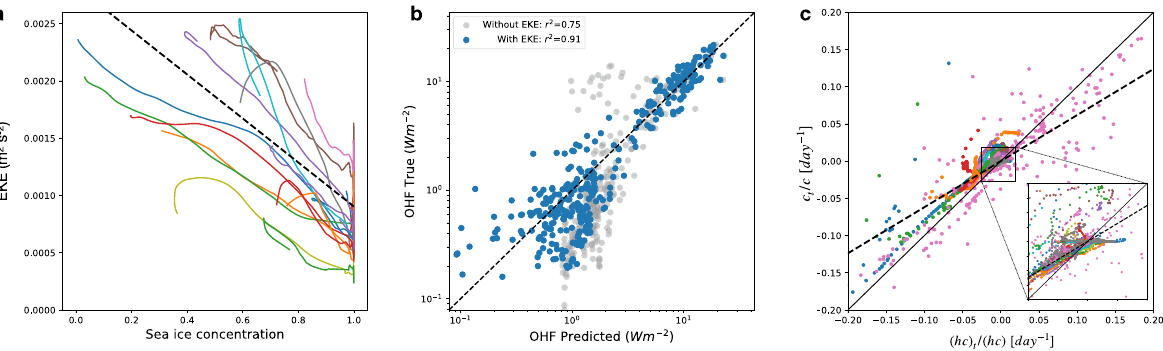
Fig. 5 Relationships between key properties in the eddy-heat fl ux feedback. a The relation between eddy kinetic energy (EKE) and sea-ice concentration; the dashed line shows the average regression based on linear regressions fi ts from individual sub-domains (colored curves). b The model-diagnosed ocean heat fl ux (OHF) compared to the predicted OHF using a linear regression with various predictors, including the EKE (blue) and excluding the EKE (gray). The 1:1 line is shown for reference and the r -squared values for gray and blue points are shown in the legend. c The normalized tendency in sea-ice concentration ( c t / c ) plotted against the normalized tendency in sea-ice volume per unit area ( hc ) t /( hc ). The solid line is a 1:1 line and the dashed line corresponds to an average regression fi t for all sub-domains with a slope of 0.6. Each line in a , c represents the temporal evolution of spatially-averaged quantities within non-overlapping 500 × 500 km sub-domains covering the entire Arctic Ocean, with a 30-day running-mean fi lter applied over all time series. Each point in b represents both the monthly and temporal mean OHF for different